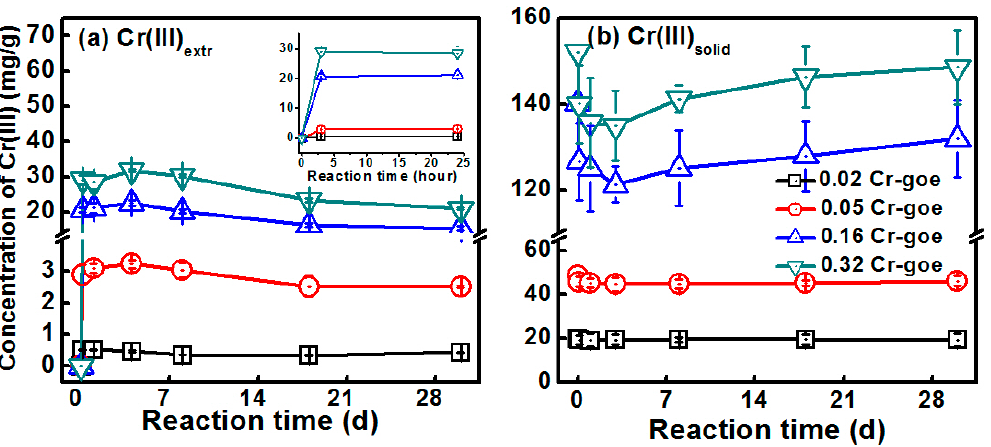
Figure 7. The concentrations of ( a ) Cr(III) extr and ( b ) Cr(III) soild during the Fe(II) aq -induced recrystallization of 1.4% Cr-goethite, 3.5% Cr-goethite, 9.03% Cr-goethite, and 10.3% Cr-goethite over 30 days. Conditions: [Fe(II) aq ] = 1 mM, [goethite] = 2 g/L, pH 7.5 controlled with 25 mM HEPEs/KBr.